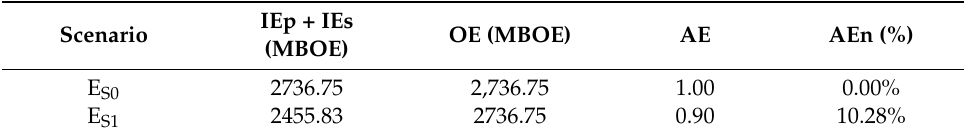
Table 10. The energy autarchy in different